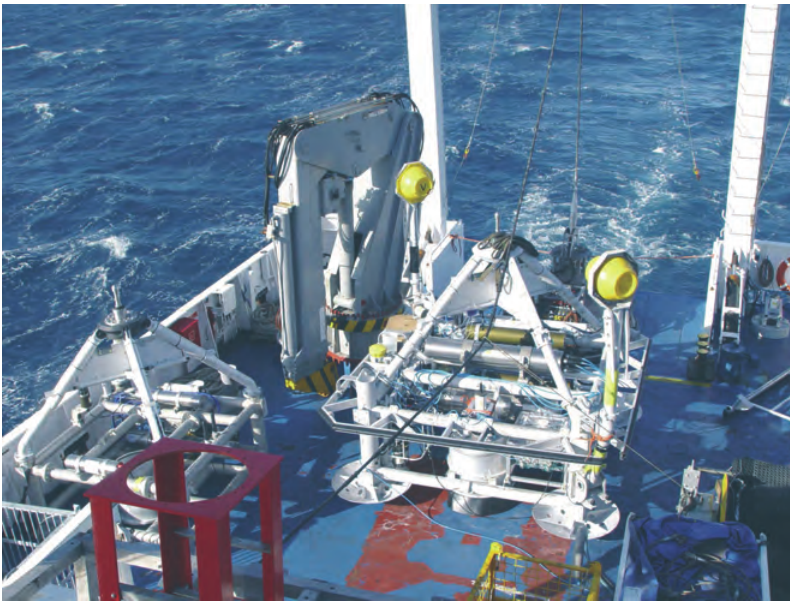
Fig. 12. GEOSTAR gateway seafloor observatory ( right ) and ORION Node 3 ( left ) on the deck of the R/V Ura- nia before the deployment at the base of Marsili underwater volcano (ORION-GEOSTAR-3 first